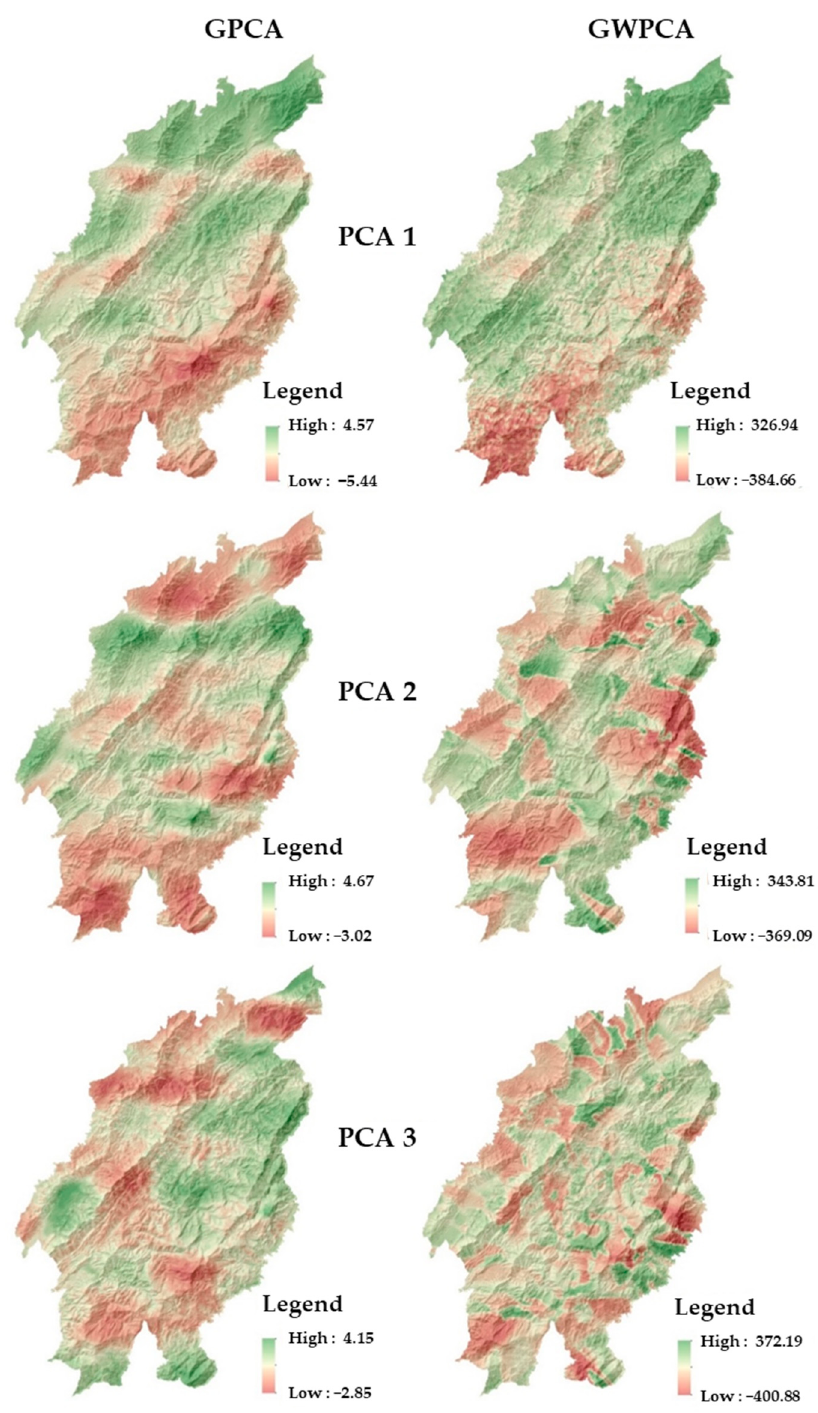
Figure 6. Principal component (PC) score maps for global principal component analysis (GPCA) and geographically weighted principal component analysis (GWPCA).